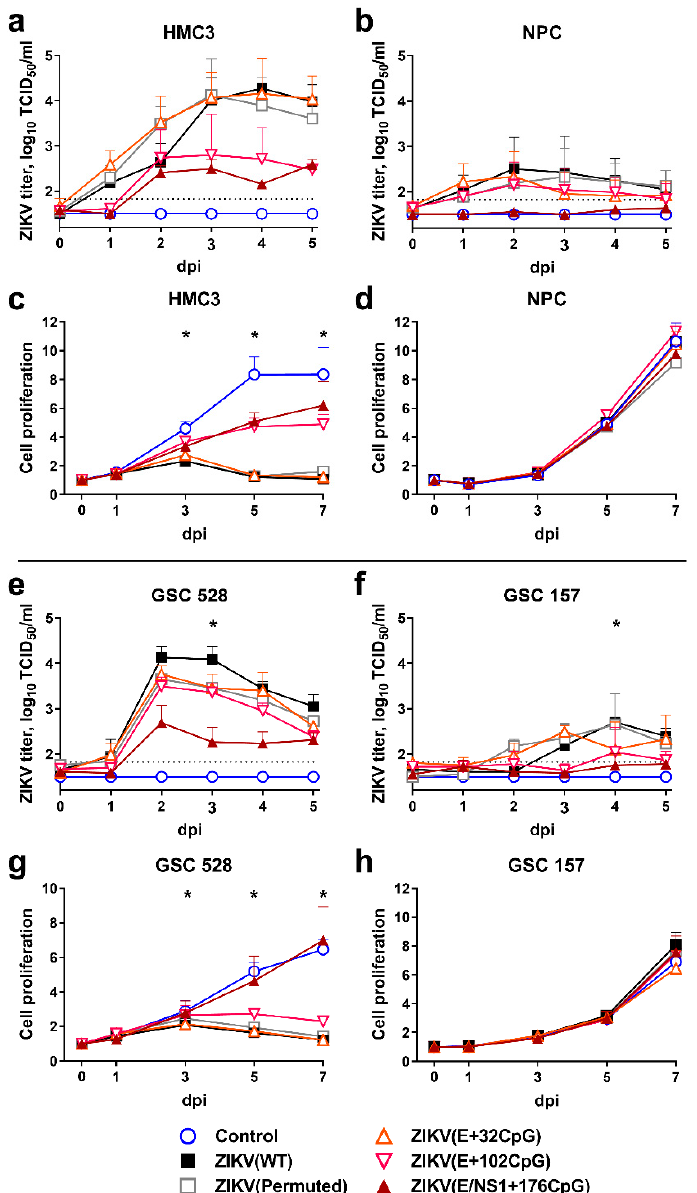
Figure 2. Infection kinetics in nonmalignant human brain cells (HMC3 ( a ) and NPC ( b )) and tumor glioblastoma stem cells (GSC 528 ( e ) and GSC 157 ( f )) after inoculation at multiplicity of infection (MOI) of 0.01. Cell culture supernatants in 96-well plates were collected and viral titers were measured using the endpoint dilution assay. The dotted line represents the limit of detection. Cell proliferation assay after inoculation of cells (HMC3 ( c ) and NPC ( d ), GSC 528 ( g ), and GSC 157 ( h )) with MOI of 1. Whiskers represent the standard error of the mean (SE) from three biologically independent replicates with three technical replicates. “dpi”—days post-inoculation. The asterisk (*) indicates p < 0.05 vs. WT ( a , b , e , f ) and control ( c , d , g , h ): ( c ) WT and E + 32CpG at 3–7 dpi, permuted control at 5–7 dpi; ( e ) E / NS1 + 176CpG at 3 dpi; ( f ) E + 32CpG and E / NS1 + 176CpG at 4 dpi; ( g ) WT, permuted control, E + 102CpG at 3–7 dpi.